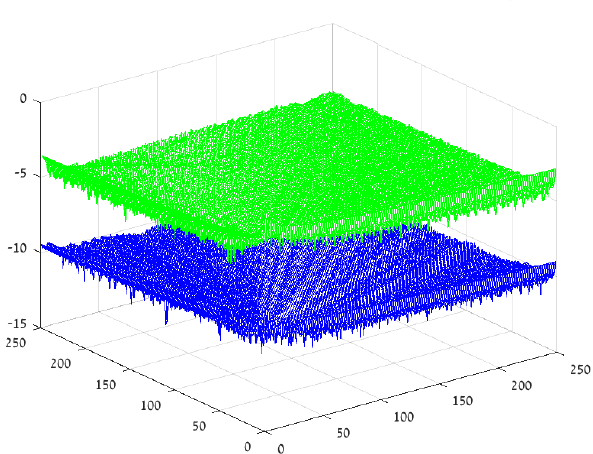
Figure 18. The approximation error with D ¯